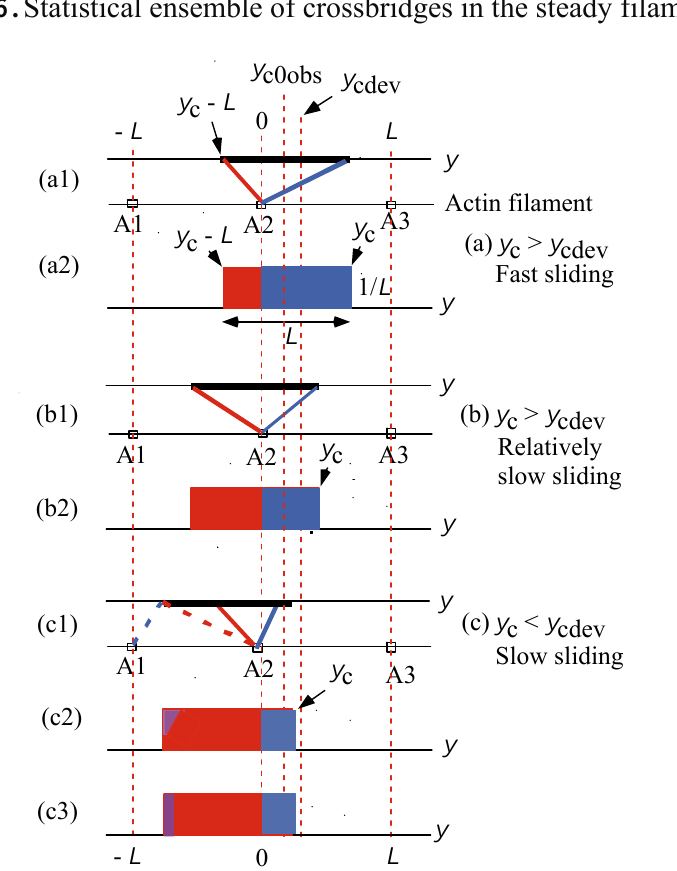
Figure 6. Statistical ensemble of crossbridges in the steady filament